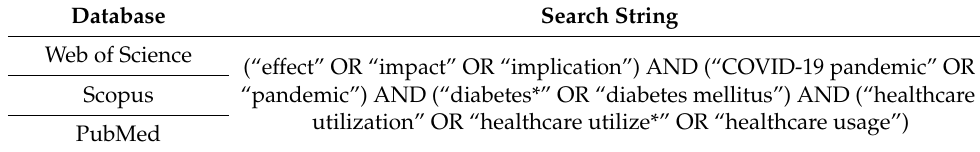
Table 1. Keyword search in the identification